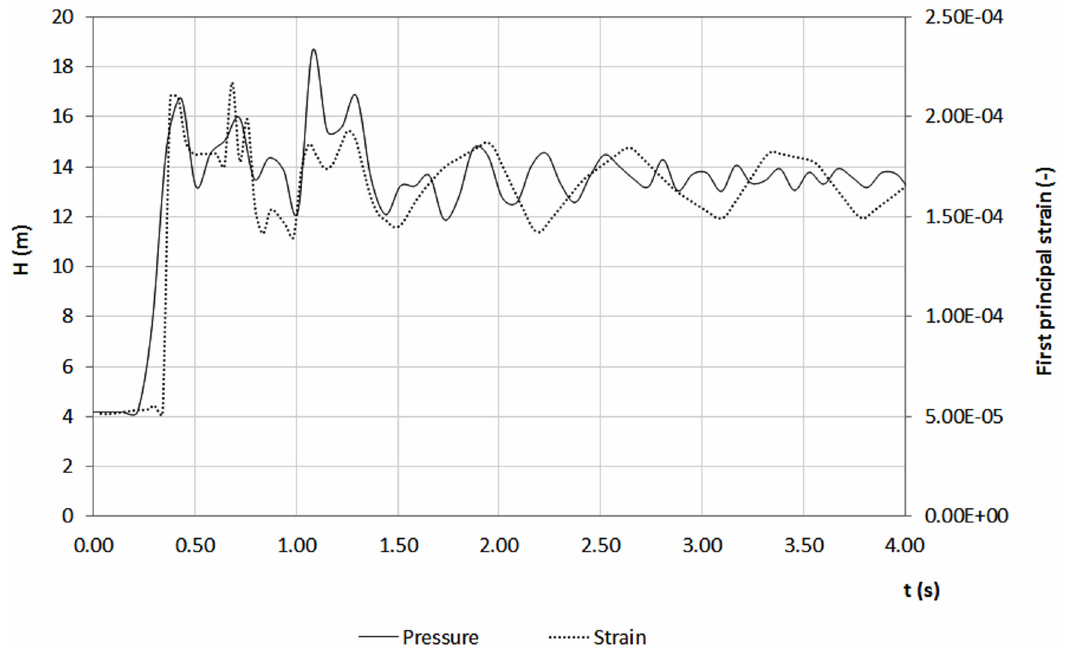
Figure 26. Pressure and first principal strain variation over time.